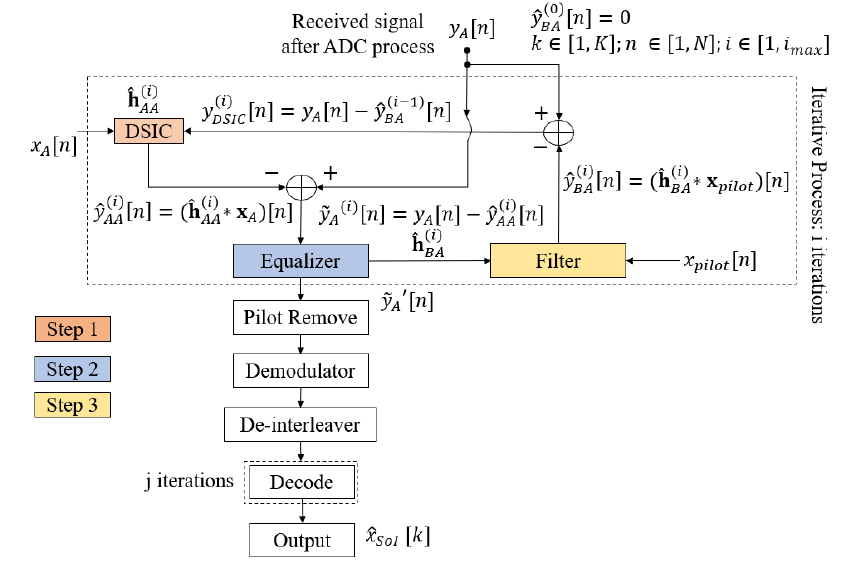
Figure 14. Joint iterative semi-blind algorithm flow